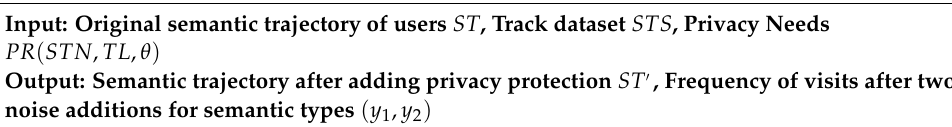
Algorithm 3. PDPST algorithm